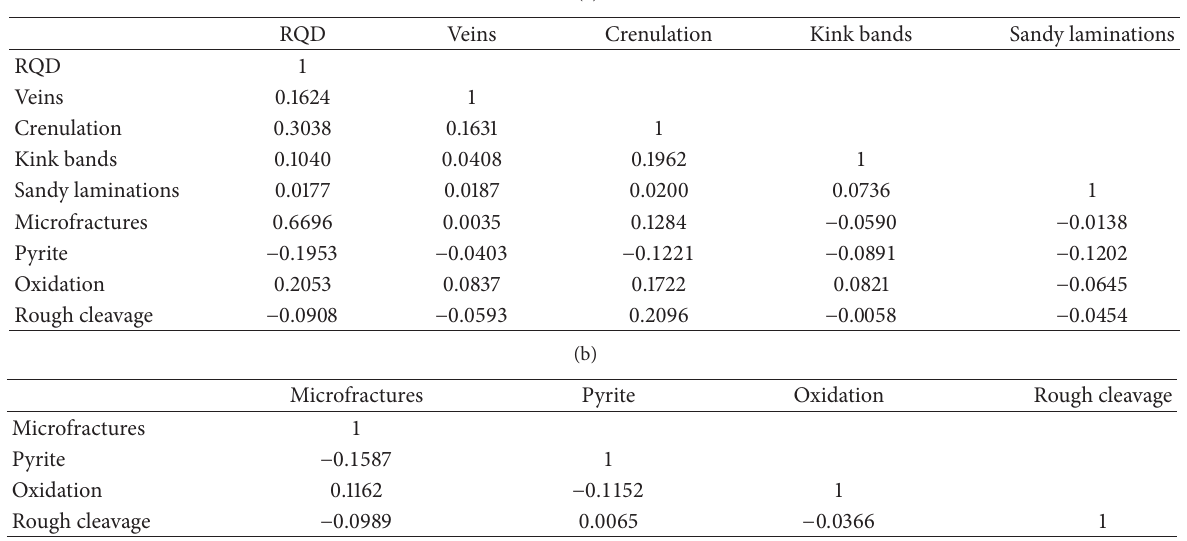
Table 1: Correlation matrix of the 𝑝 = 9 explanatory variables that affected the results of borehole